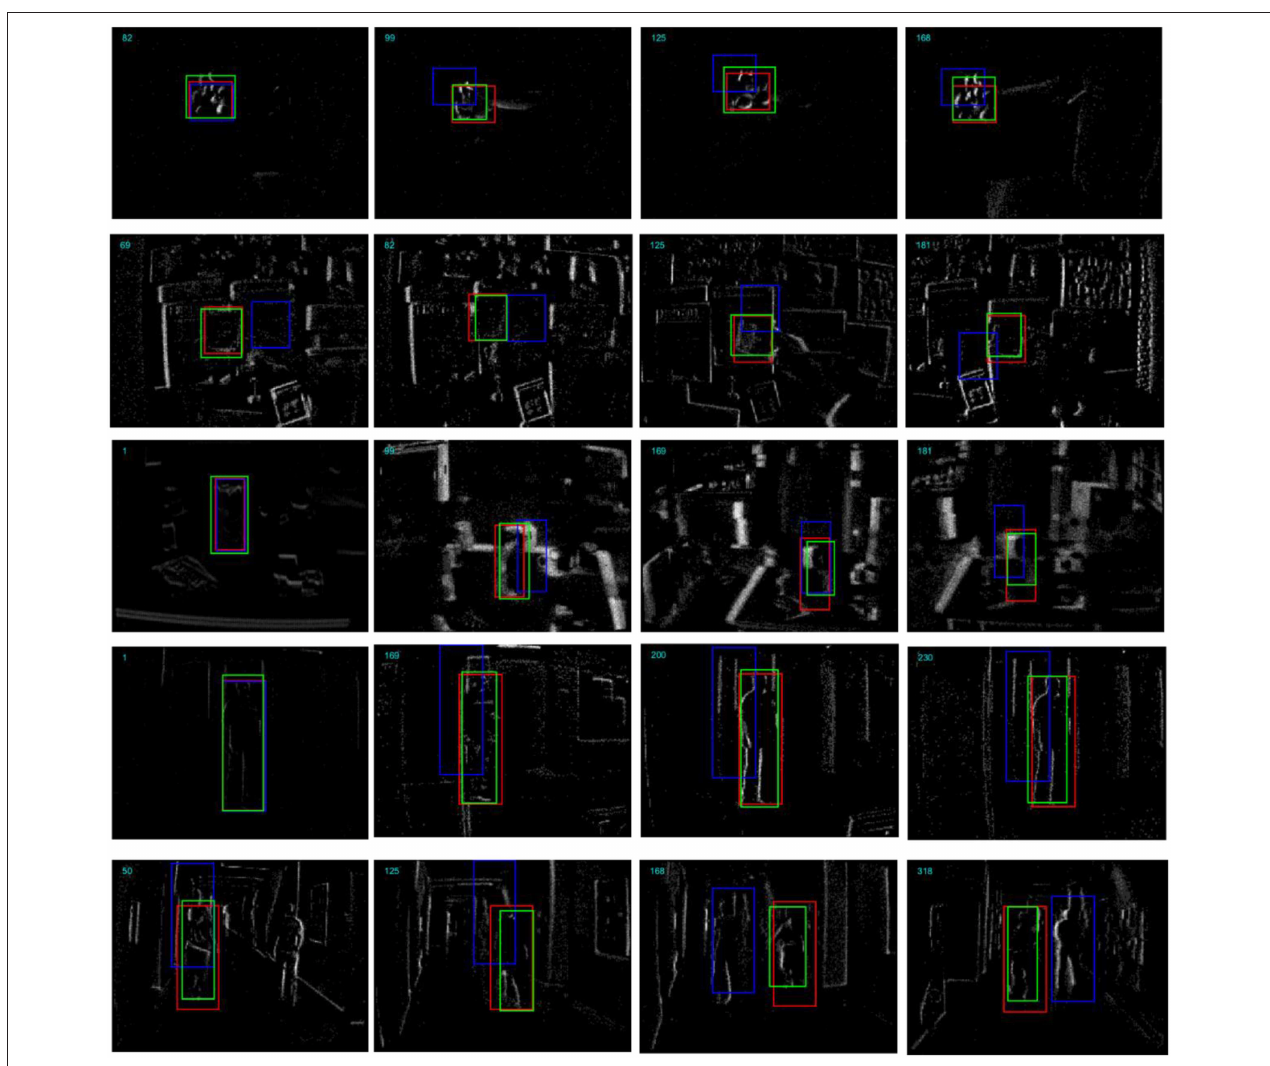
FIGURE 7 | Comparison of the proposed tracking method with the compressive sensing based method on example segments from the five DAVIS recordings. From top to bottom are the “Sylvestr,” “Vid_B_cup,” “Vid_C_juice,” “Vid_E_person_part_occluded,” and “Vid_J_person_floor,” respectively. The bounding boxes with green, red, and blue color represent the groundtruth, our proposed tracker and the compressive sensing based tracker,